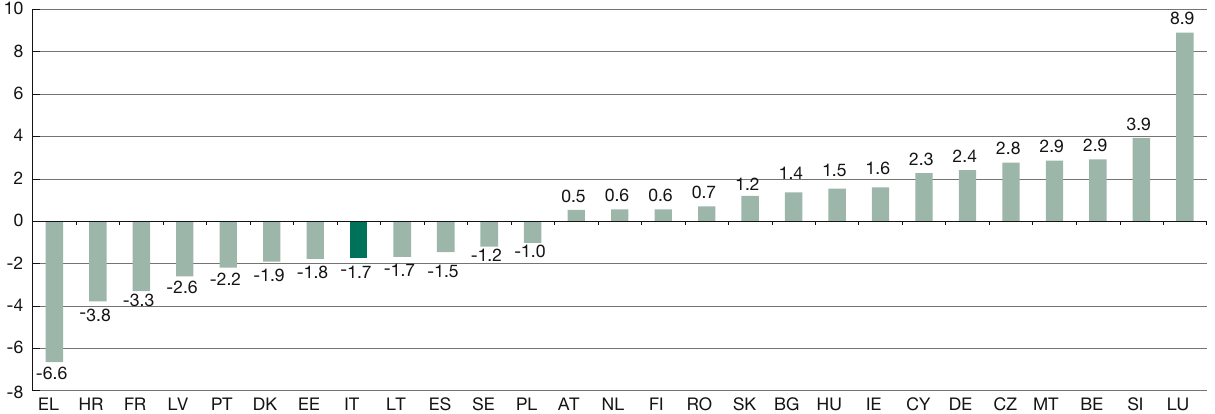
Figure 2 Change in public pension expenditure 2016-2070, EU countries percentage points of GDP